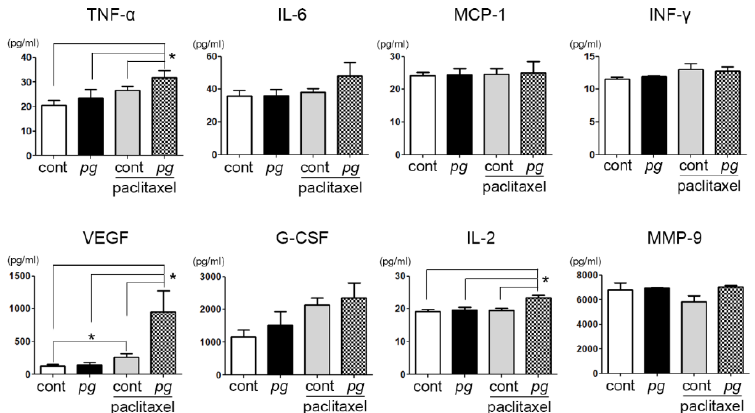
Figure 4. Comparisons of the serum cytokines in ibuprofen-treated mice that were administered P. gingivalis and/or paclitaxel. Data are presented as the mean ± standard deviation. Significance was assessed using ANOVA. * P < 0.05.